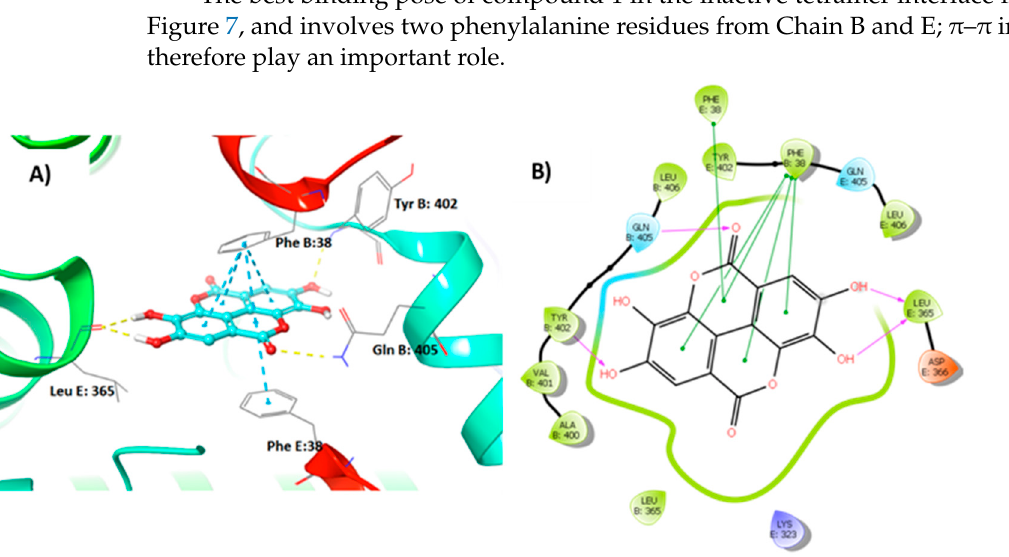
Figure 7. Compound 1 interactions with PKL tetramer. ( A ) 3D structure of the binding pose. ( B ) 2D structure of the binding pose.